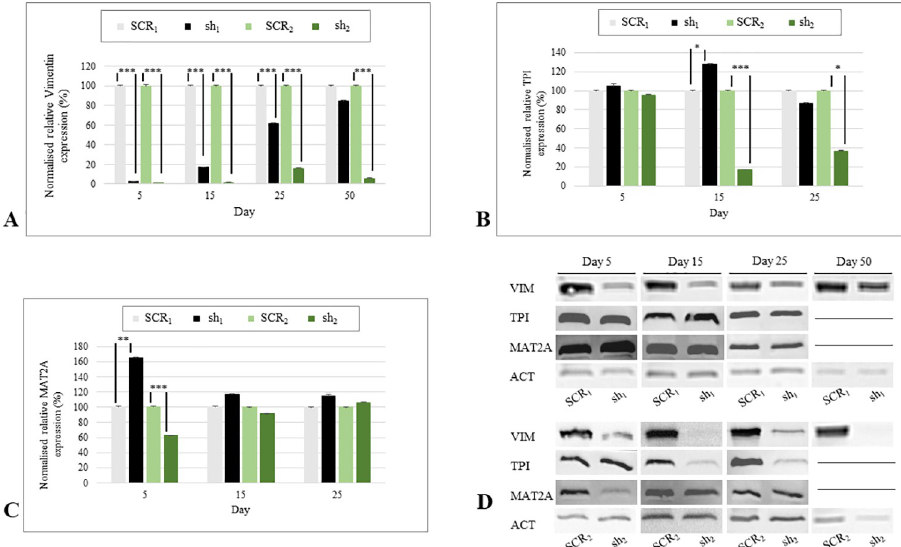
Fig 5. mRNA and protein expression of VIM, TPI and MAT2A in knockdown cells. A. Median and standard error of relative VIM mRNA expression of sh 1 , SCR 1 , sh 2 , SCR 2 . VIM was significantly downregulated in sh 1 and sh 2 at each investigation day ( p < 0.001), except of day 50 in sh 1. Statistical analysis was carried out using Mann–Whitney U test for unpaired data. B. Relative mRNA expression of TPI of sh 1 , SCR 1 , sh 2 , SCR 2 . TPI was significantly upregulated in sh 1 at day 15 ( p < 0.05) and downregulated in sh 2 at day 15 ( p < 0.001), and 25 ( p < 0.05). Statistical analysis was carried out using Mann–Whitney U test for unpaired data. C. Median and standard error of relative MAT2A mRNA expression of sh 1 , SCR 1 , sh 2 , SCR 2 . MAT2A was significantly upregulated in sh 1 ( p < 0.01), and downregulated in sh 2 at day 5 ( p < 0.001) . Statistical analysis was carried out using Mann–Whitney U test for unpaired data. D. Western blot analysis of VIM, TPI and MAT2A in sh 1 , SCR 1 , sh 2 , SCR 2 at day 5, 15, 25. ACT was used as internal control. � p < 0.05, �� p < 0.01, ��� p <